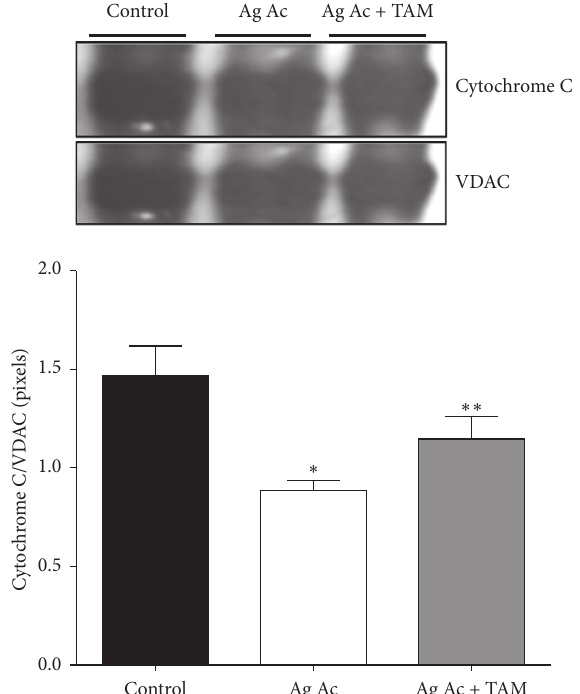
Figure 4: Agaric acid-induced detachment of cytochrome c and its protection by tamoxifen. Experimental conditions were as described in Materials and Methods. Data represent mean ± SD of, at least, three different experiments ∗ p < 0 . 05 vs. control; ∗∗ p < 0 . 05 vs. Ag Ac. The image is representative of, at least, 3 different